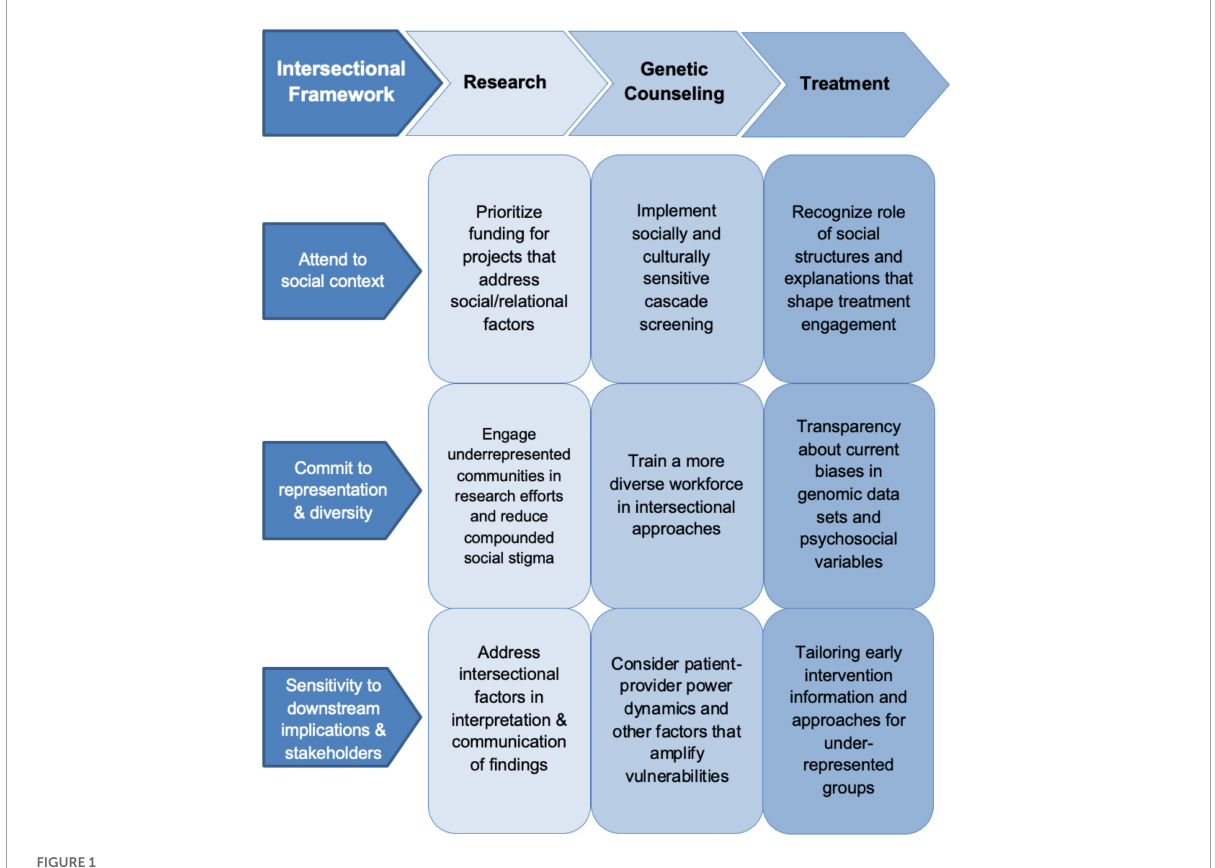
FIGURE1 Intersectional framework psychiatric